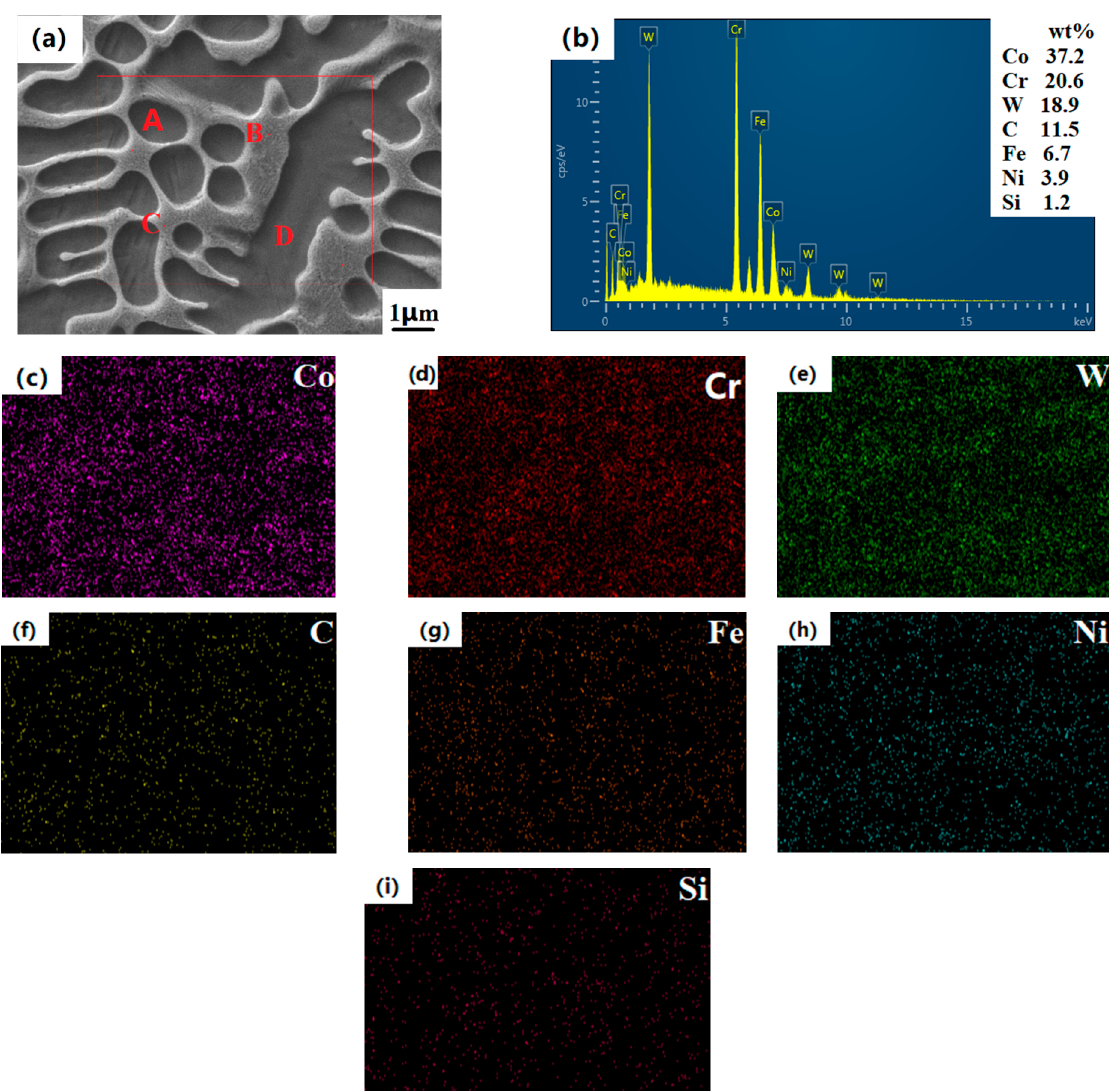
Figure 6. EDS surface scanning analysis of the middle area of the Co-Cr-30%WC cladding section. ( a ) Surface scanning area; ( b ) EDS surface total spectrum; ( c ) Co element distribution; ( d ) Cr element distribution; ( e ) W element distribution; ( f ) C element distribution; ( g ) Fe element distribution; ( h ) Ni element distribution; ( i ) Si element distribution.